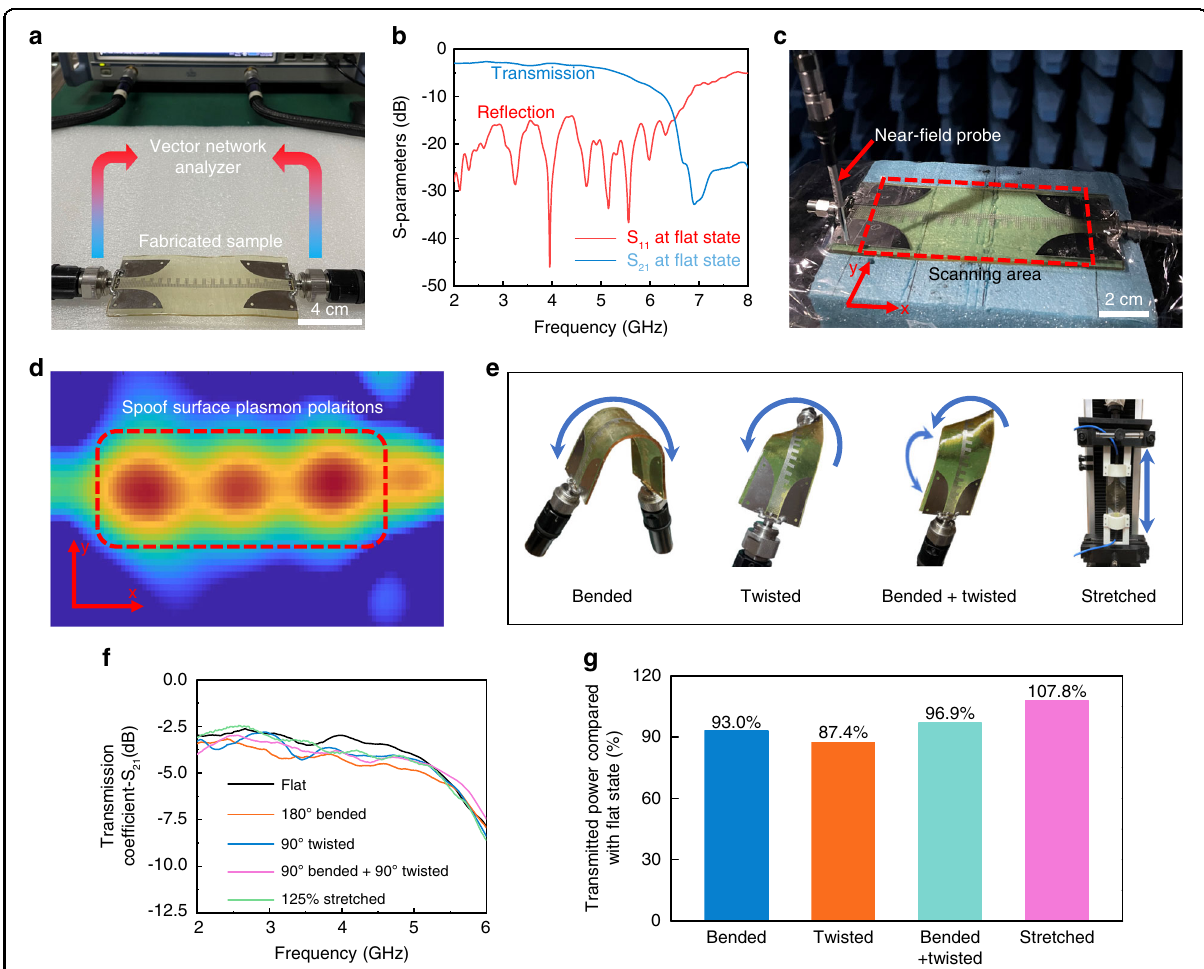
Fig. 4 Measurement of the undamaged spoof plasmonic meta-waveguide. a Experimental photograph of the meta-waveguide in the fl at state. b Measured S-parameters of the fl at sample. c Near- fi eld distribution measurement of the meta-waveguide. d Measured near- fi eld distributions of the meta-waveguide. e Experimental photograph of the meta-waveguide with different deformed state. f Measured transmission coef fi cients and g power comparison of the deformed